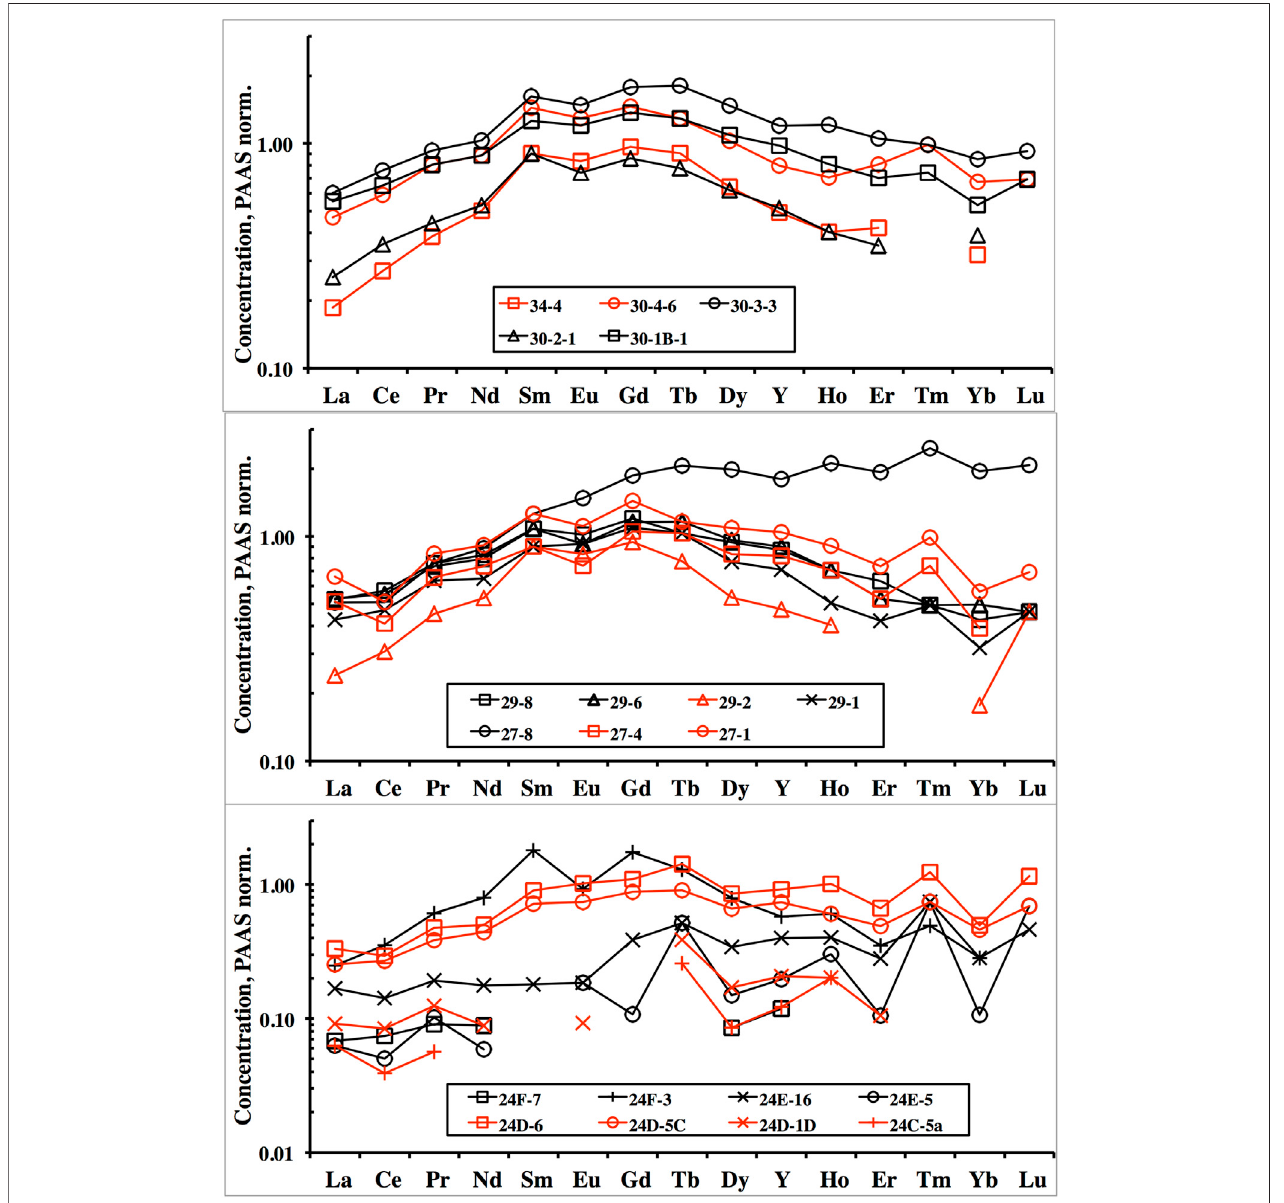
FIGURE 7 | Rare earth element patterns of acetic acid extracts. All data have been multiplied by 1,000 to plot on a scale comparable to the whole rock data.